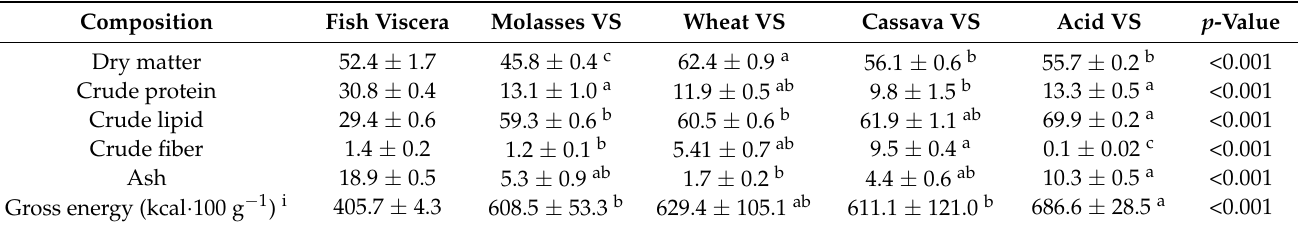
Table 2. Proximate composition of fish viscera and silages after 7 days of storage (% dry